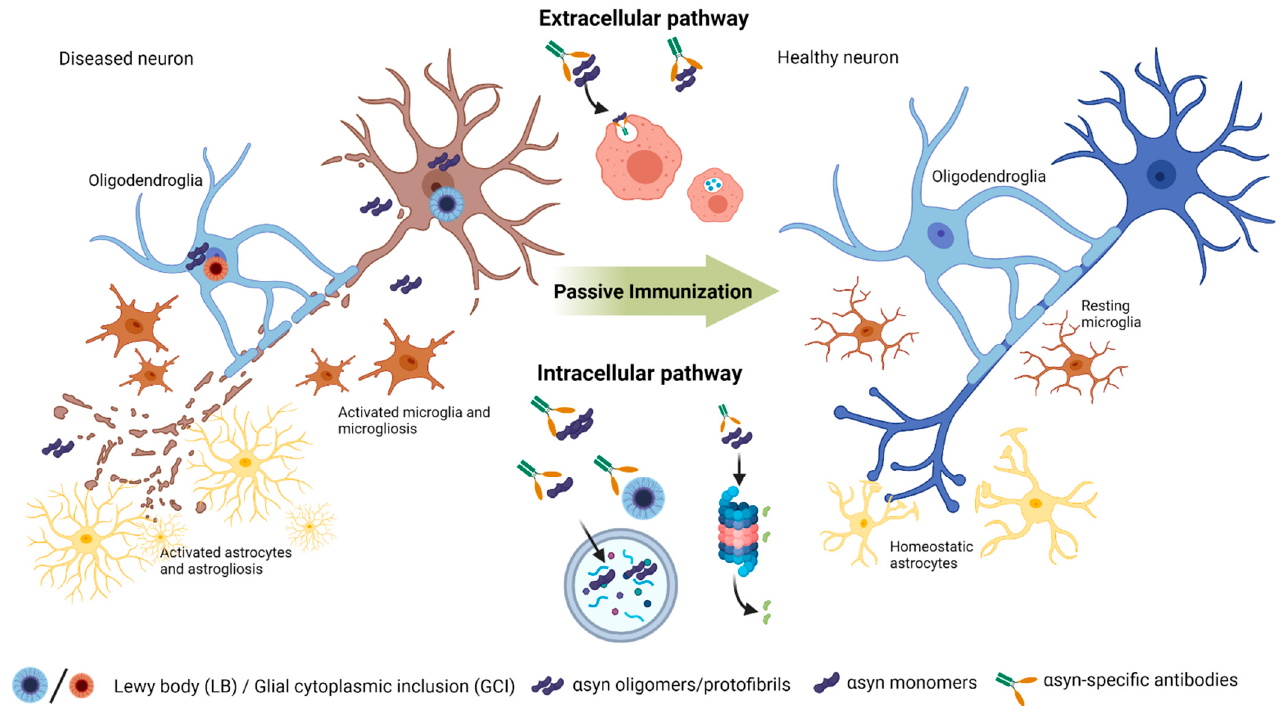
Figure 1. Clearing process of pathogenic alpha-synuclein ( α syn) using naturally occurring α syn conformation-specific antibodies in passive immunization. In synucleinopathies, pathogenic α syn species (proto/fibrillary or oligomeric) accumulate and potentially seed monomeric α syn facilitating transmission, and additionally triggering microglial and astrocytic activation. In PD and DLB, α syn aggregates in neurons form LBs. Whereas in MSA, α syn accumulates in oligodendroglial cells, forming GCIs. Administration of α syn-specific antibodies could facilitate clearance of pathogenic α syn in the extracellular space by phagocytosis reducing transmission of pathogenic species or enable intracellular antibody-aided autophagy and proteosomic degradation, both pathways leading to reduced pathogenic α syn and rescue of neuronal degradation. Created using Biorender.com (accessed on 6 January 2022).